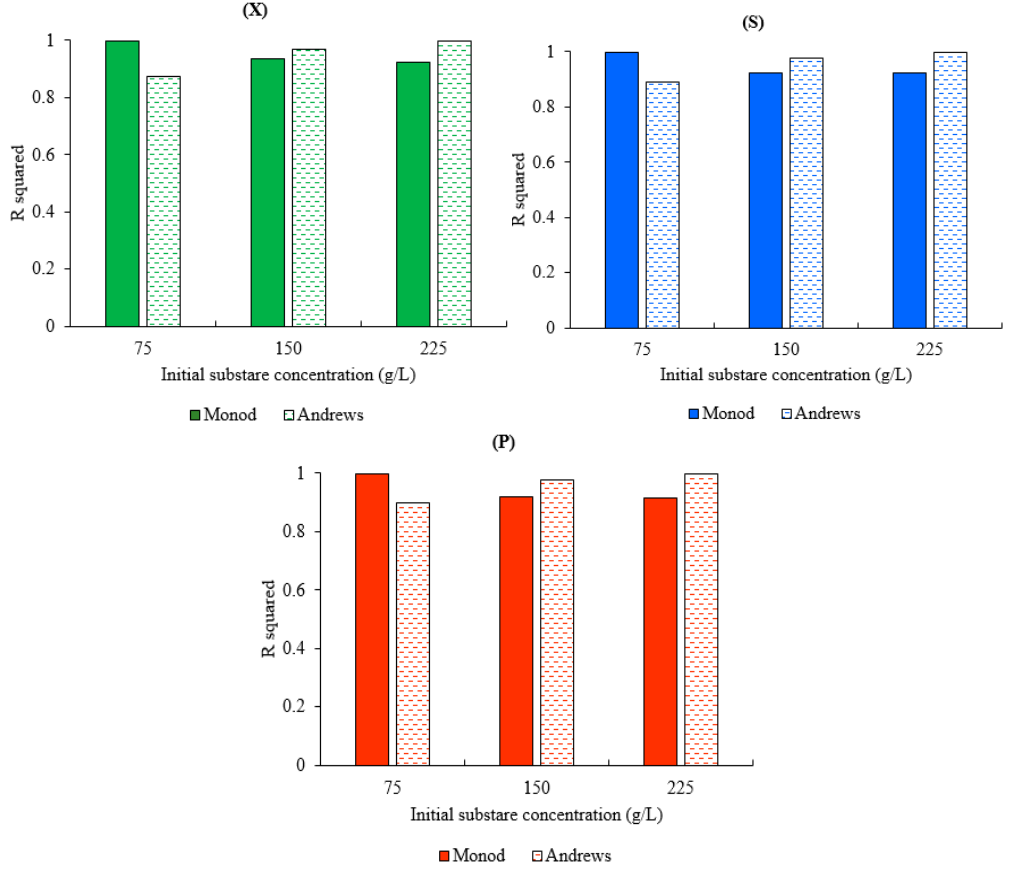
Figure 5. R 2 of both models for x 0 = 1 g.L − 1 at di ff erent initial substrate concentrations: ( X ) R 2 for the biomass concentration, ( S ) R 2 for the substrate concentration, and ( P ) R 2 for the ethanol concentration.